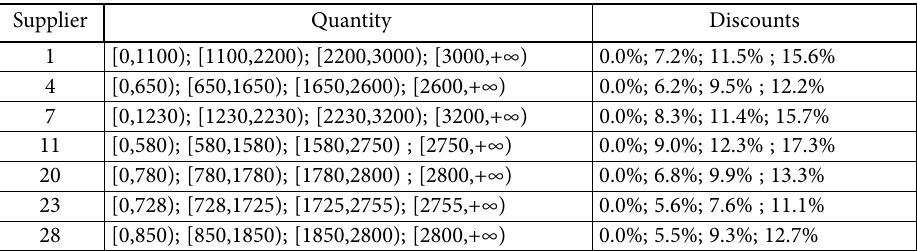
Table 34. All-unit quantity discounts provided by candidate